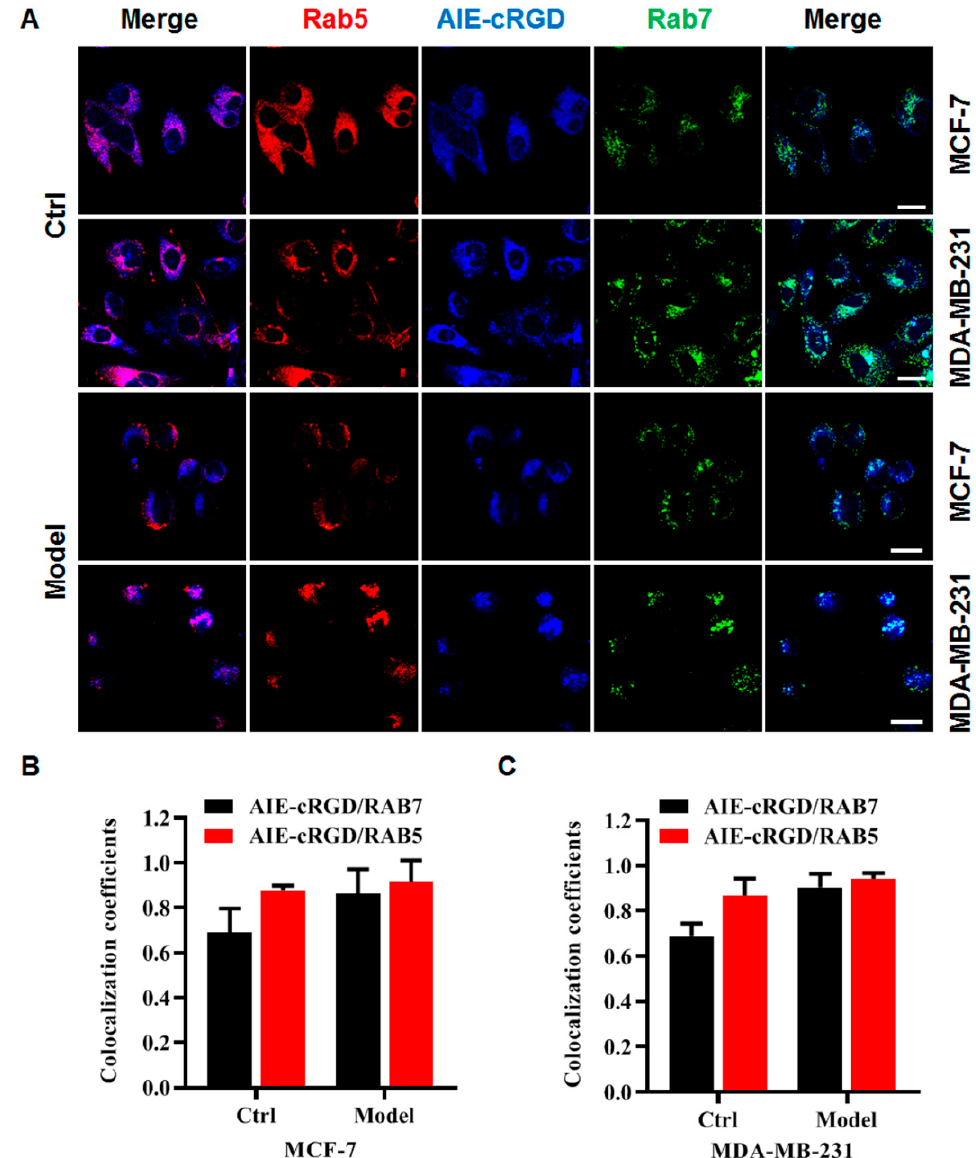
Figure 5. The distribution of integrin clusters in cancer cells. ( A ) Confocal fluorescence microscopy images of MCF-7, MDA-MB-231 cells with different treatments stained with AIE–cRGD, Rab5, Rab7, respectively. Colocalization coefficients of AIE–cRGD with RAB5 or RAB7 in control cells and model cells of MCF-7( B ), MDA-MB-231( C ) cells, respectively. Bar = 20 μ m.